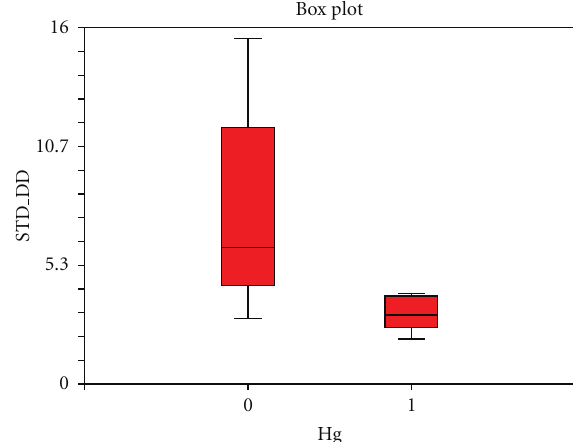
Figure 3: Box plots showing the variance (standard deviation; STD) of hydrogen isotope ratios along the length of the hair in Huancavelica residents (1) and controls (0). The statistically significant reduced variance in Hg exposed individuals ( P = 0 . 01) signifies deranged biologic rhythms with significant reduction of variance in the system’s control by the autonomic nervous system.